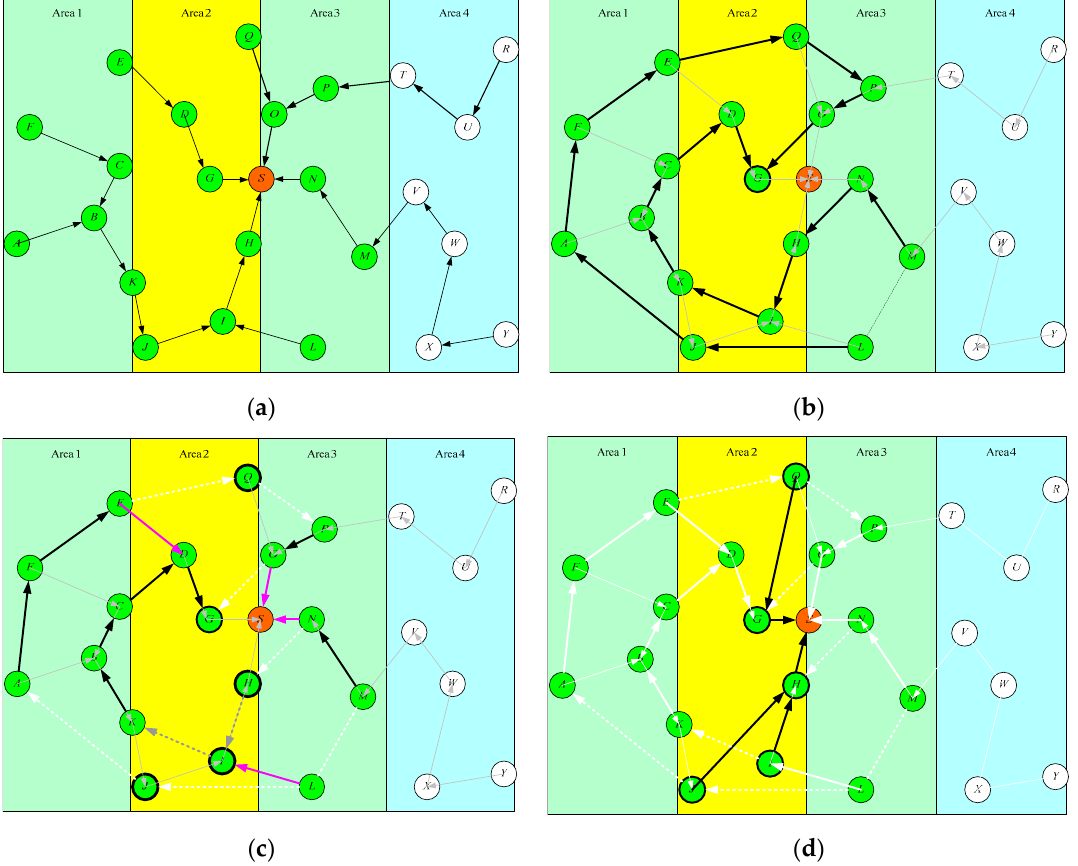
Figure 3. Example of charging area aware multi-mode data gathering method. ( a ) construct the minimum spanning tree of the vertices rooted at the sink; ( b ) type1 and type2 sensors are merged as a chain; ( c ) update the next receivers of the type2 sensors in the constructed chain of (b) to save energy; ( d ) the type1 sensors update their next receivers.